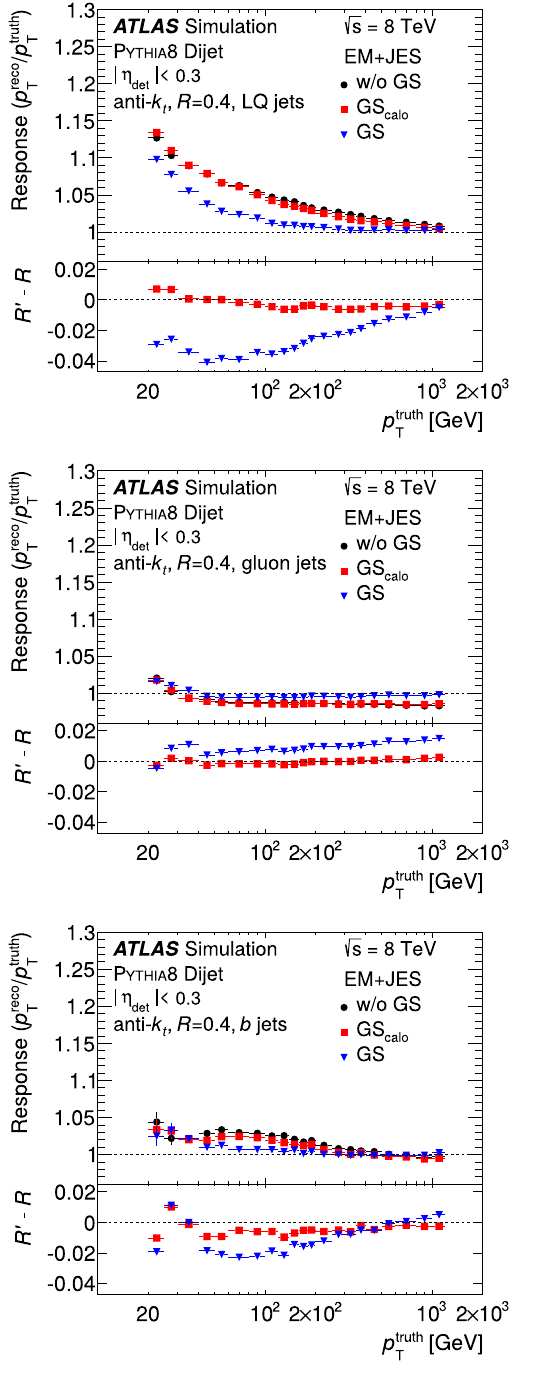
Fig. 12 The p T response for anti- k t R = 0 . 4 jets as a function of p truth for light quark (LQ) jets (top), gluon jets (middle) and b -jets (bot- T tom) with | η det | < 0 . 3 (left) and 2 . 1 < | η det | < 2 . 4 (right) regions in the Pythia8 MC sample. The p T response after the EM+JES cal- ibration without GS corrections (circles), with calorimeter-based GS